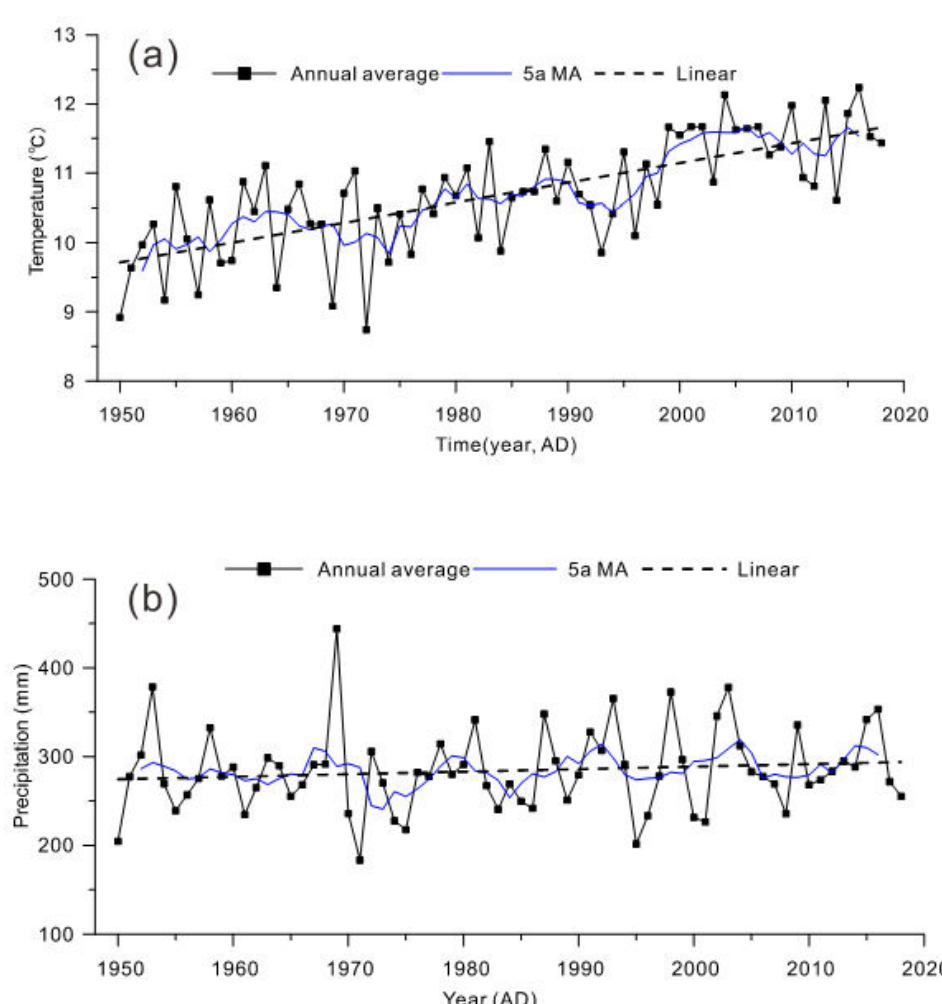
Figure 2. ( a ) Temperature change of the Aral Sea Basin from 1950 to 2018; ( b ) the annual average precipitation variations of the Aral Sea Basin. The blue lines demonstrate the five-year moving average (5a MA) and the dashed lines for the linear fitting. Note: This figure is original and the data used for Figure 2 were extracted from the CRU datasets